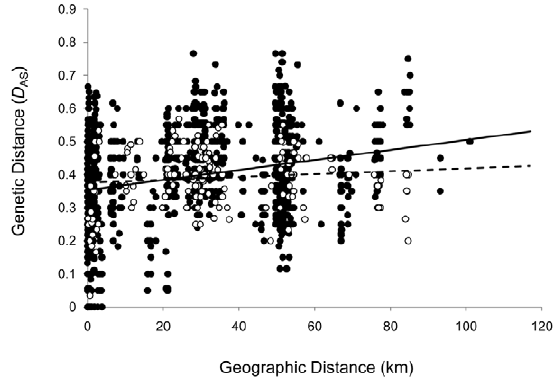
Figure 3. Spatial genetic analysis among T.cruzi isolates from LOJA Sylv and LOJA Dom/Peri . A spatial structure was evident within LOJA Sylv isolates, while no spatial genetic structure was found among LOJA Dom/Peri isolates. Genetic ( D AS ) and geographic (km) distance were compared. Closed circles and line correspond to samples from LOJA Sylv (R XY =0.265, p=0.000; Slope=0.0015 6 0.0001 (SE)); open circles and dashed line correspond to samples from LOJA Dom/Peri (R XY =0.100, p=0.164; Slope=0.0004 6 0.0004 (SE)). Equivalent statistics under dm 2 are LOJA Sylv R XY =0.177, p=0.001; LOJA Dom/Peri R XY = 2 0.052,